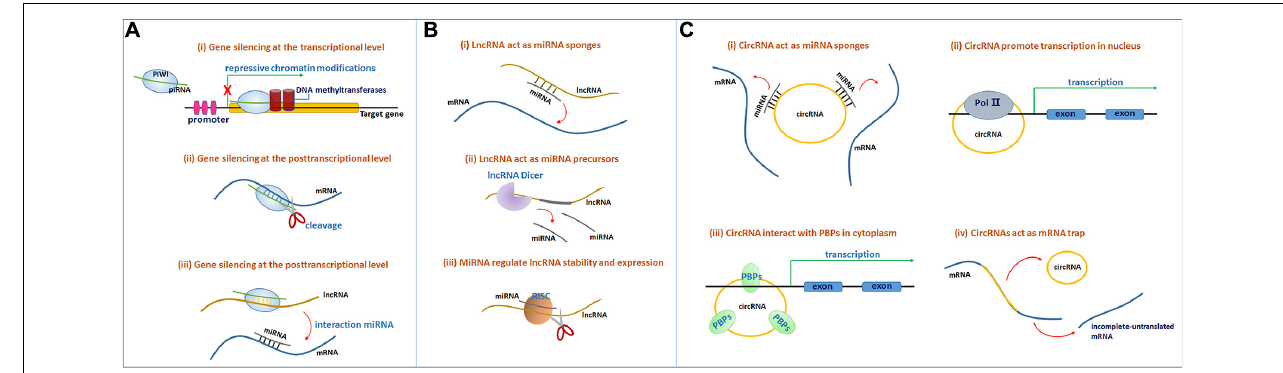
FIGURE 1 | (A) The molecular mechanisms of the PIWI-piRNA pathway. The PIWI protein and piRNA form a complex. (i) Gene silencing at the transcriptional level. The PIWI-piRNA complex through recruiting a chromatin methylation complex to the nucleus, often serve as repressive chromatin modification. (ii) Gene silencing at the posttranscriptional level. PIWI protein serve as the endonuclease activity to inducing the cleavage of the target mRNAs in the cytoplasm. (iii) PiRNAs through binding to lncRNAs, release miRNAs from the binding sites of lncRNAs to induce target mRNA degradation. (B) Mechanisms of lncRNA-miRNA interaction. (i) LncRNAs act as miRNAs sponges. LncRNAs can sponges miRNAs through miRNA reaction elements (MREs) and suppress the targeting mRNAs degradation mediated by miRNAs. (ii) LncRNAs can function as miRNA precursors that generate specific miRNAs by intracellular RNA splicing and enhance the posttranscriptional regulation of target mRNAs. (iii) MiRNAs in RISCs can target and reduce some lncRNAs stability through imperfect base-pairing. (C) (i) CircRNAs function as miRNA sponges to bind to miRNAs and inhibit target mRNAs degradation. (ii) CircRNAs interact with the Pol II complex in the nucleus to influence mRNA transcriptional levels. (iii) CircRNAs bind to RNA-binding proteins (RBPs) to influence mRNA transcriptional levels. (iv) CircRNAs function as mRNA trap to influence mRNA splicing and protein